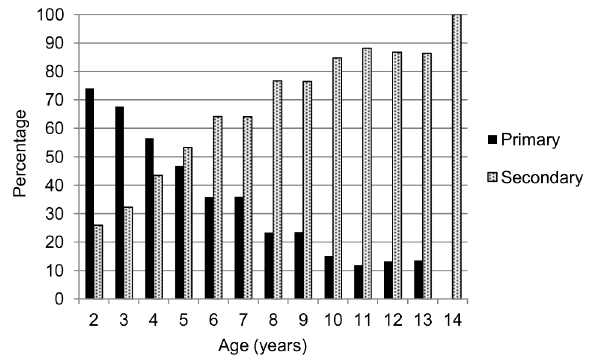
Figure 5. Percentage of primary and secondary DENV infec- tions in the cohort by year of age. The percentage of primary and secondary immune responses, by age, from 2004–2005 to 2007–2008 has been previously reported